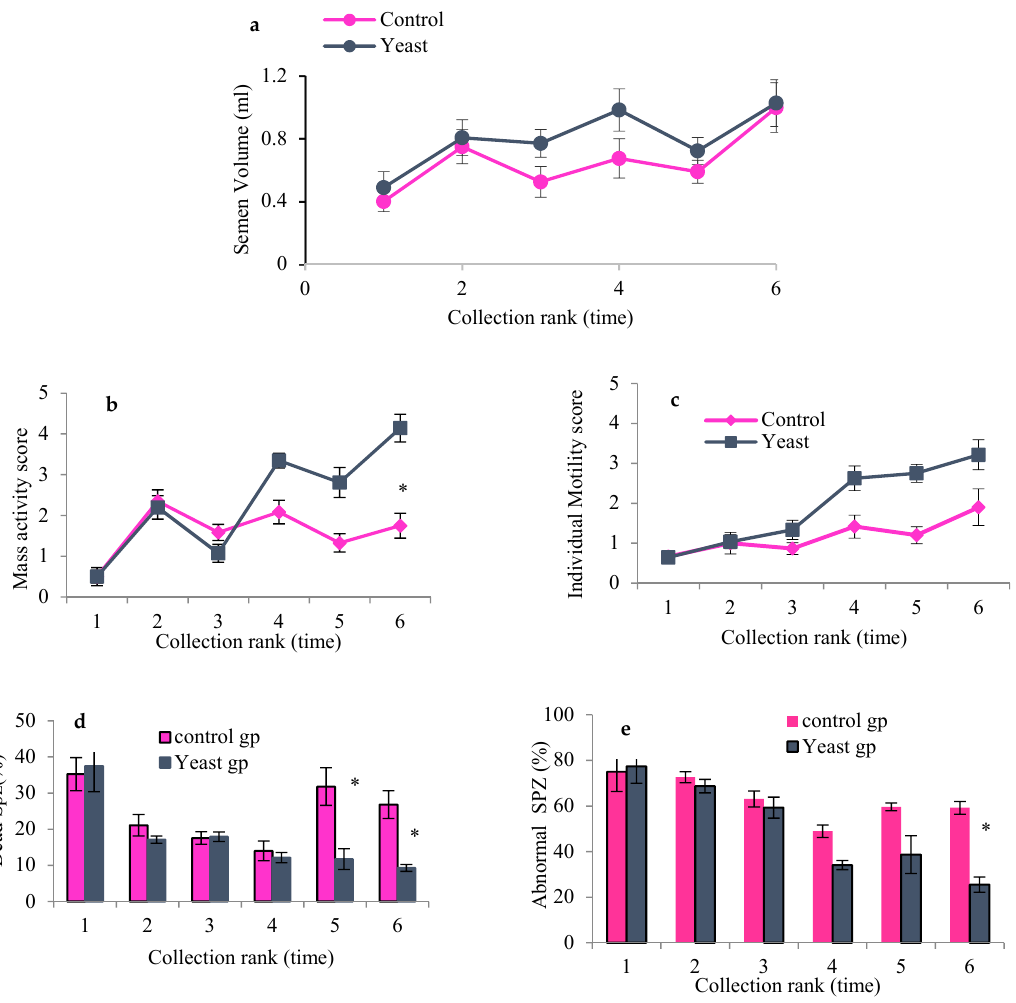
Figure 1. Variation in ( a ) ejaculate volume, ( b ) mass motility score, ( c ) individual motility, ( d ) dead spermatozoa rate and ( e ) abnormal spermatozoa rate in yeast-treated and control rams. Effect of supplementation is significant, * P <0.05.